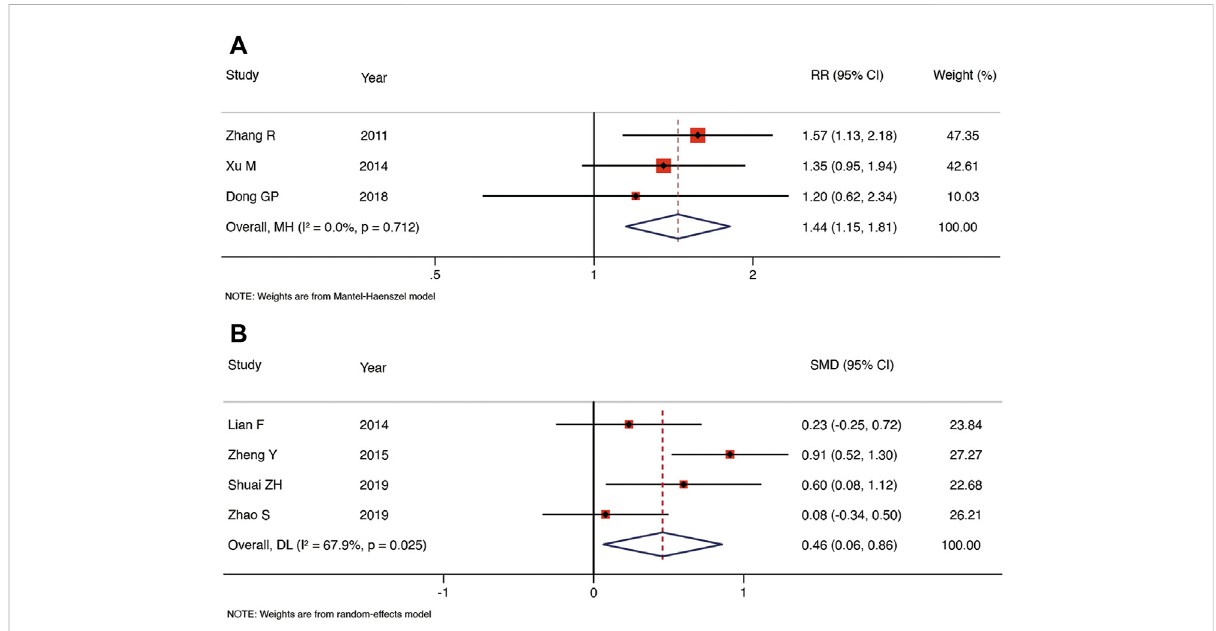
FIGURE 5 Meta-analysis of biochemical pregnancy rate (A) and the number of oocytes retrieved (B) after exclusion of